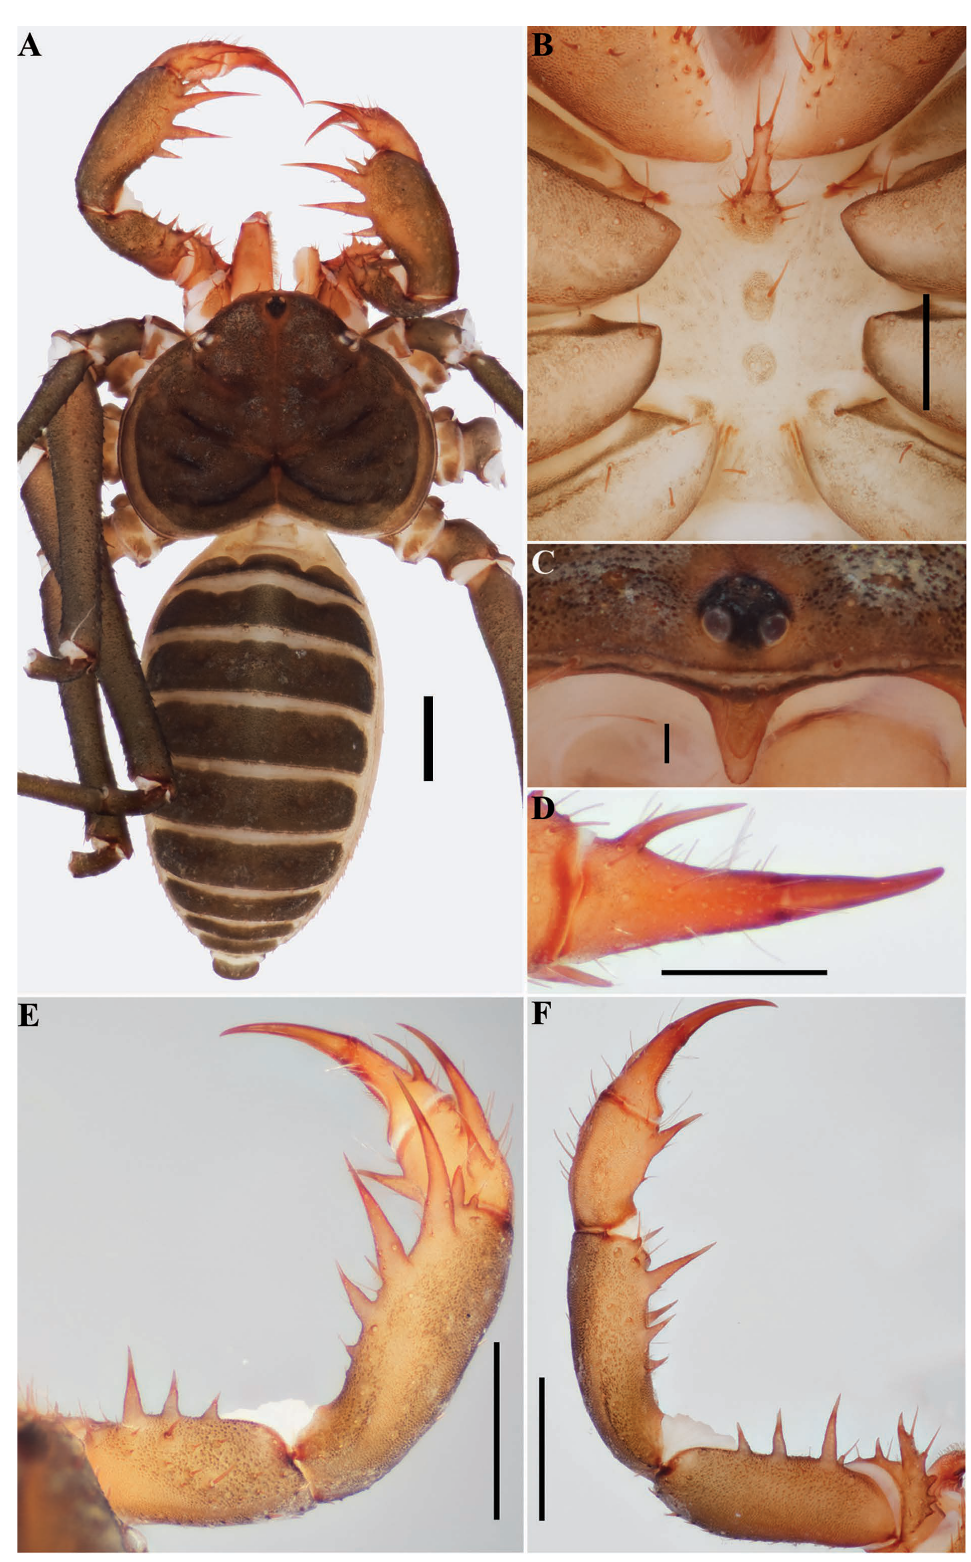
Fig. 141. Sarax cochinensis (Gravely, 1915) (AMCC [LP 13118]), general morphology, ♀ . A . Habitus, dorsal view. B . Sternum, ventral view. C . Frontal process. D . Pedipalp tarsus, frontal view. E . Pedipalp, dorsal view. F . Pedipalp, ventral view. Scale bars: A–B, E–F = 1 mm; C = 0.1 mm; D =